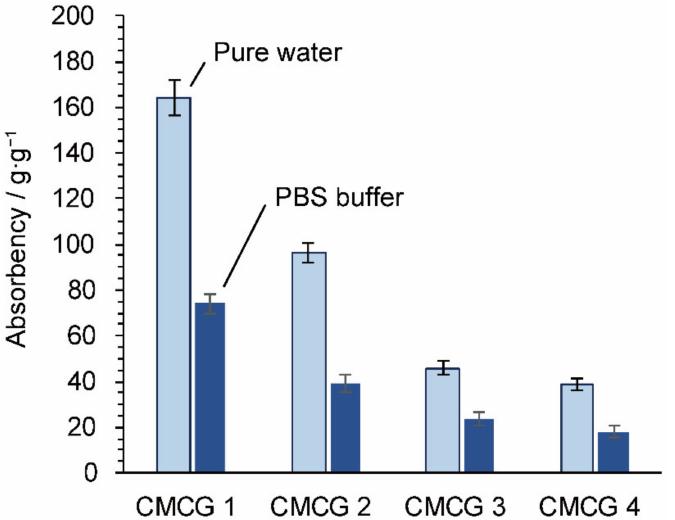
Figure 10. Absorbency of the CMCG 1–4 species toward pure water and phosphate-buffered saline after 24 h at 298 K.